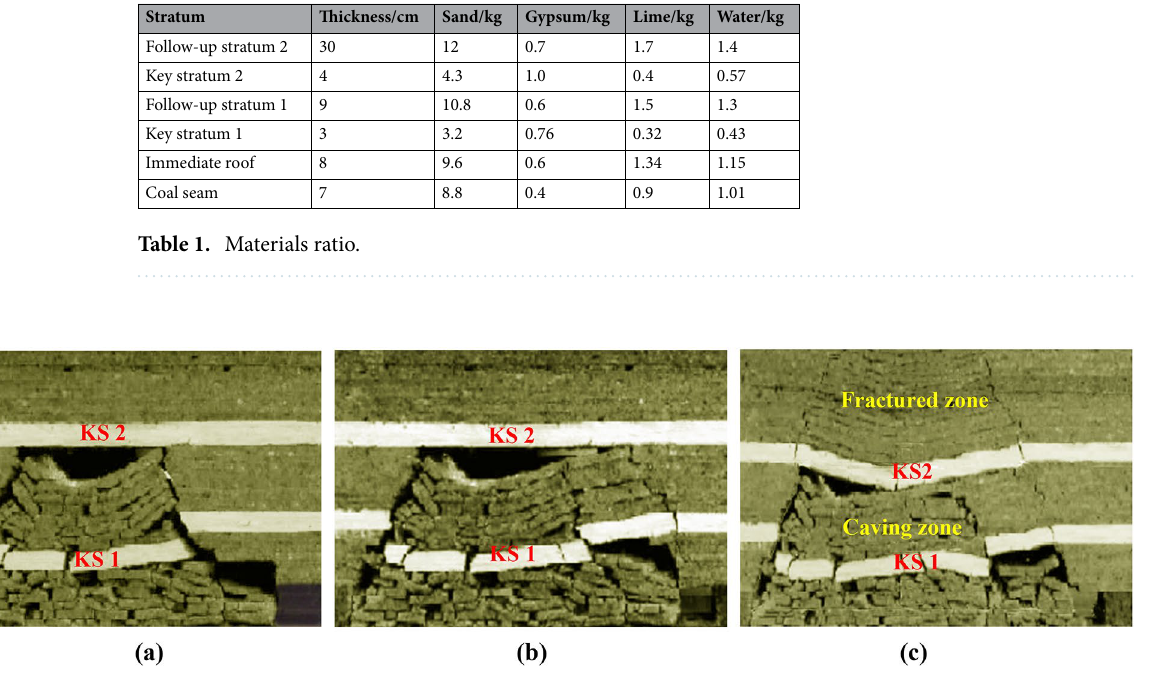
Figure 3. Experimental process: ( a ) advanced to 56 m, ( b ) advanced to 63 m, and ( c ) advanced to 87